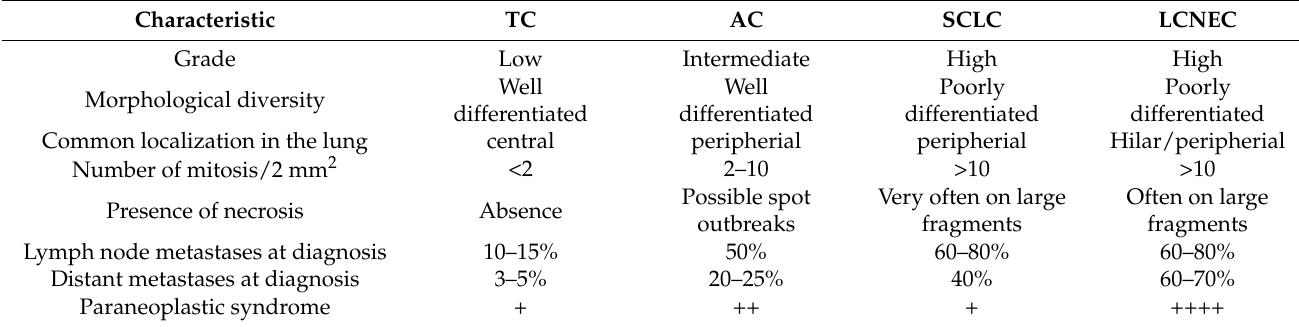
Table 2. Characteristics of lung neuroendocrine neoplasms based on [50,51].